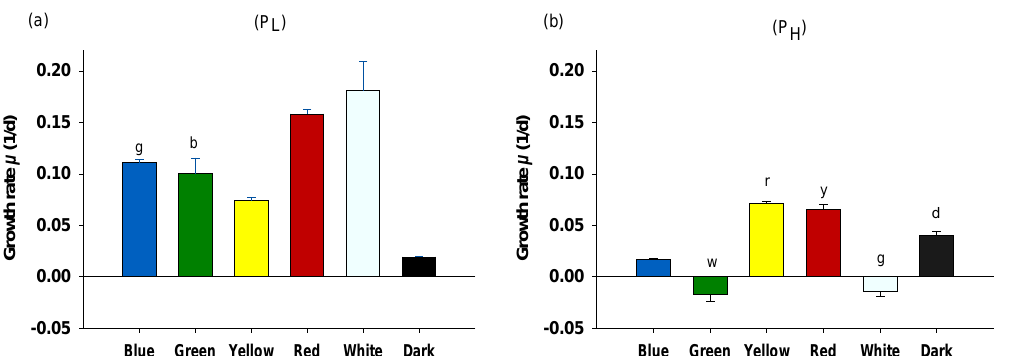
Figure 1. Growth rates of A. protothecoides cultivated photoautotrophically for seven days with different light wavelengths: ( a ) with low peptone (P L ) and ( b ) with high peptone (P H ). Each bar represents the average ± SD of n = 3 replicates. The letters (b: blue, g: green, y: yellow, r: red. w: white, and d: dark) indicate that there were no statistically significant differences between the means (two-way ANOVA; Duncan method; p < 0.05) of the pairwise comparisons between the different wavelengths. Between the variable groups P L and P H there were statistically significant differences ( p < 0.01).